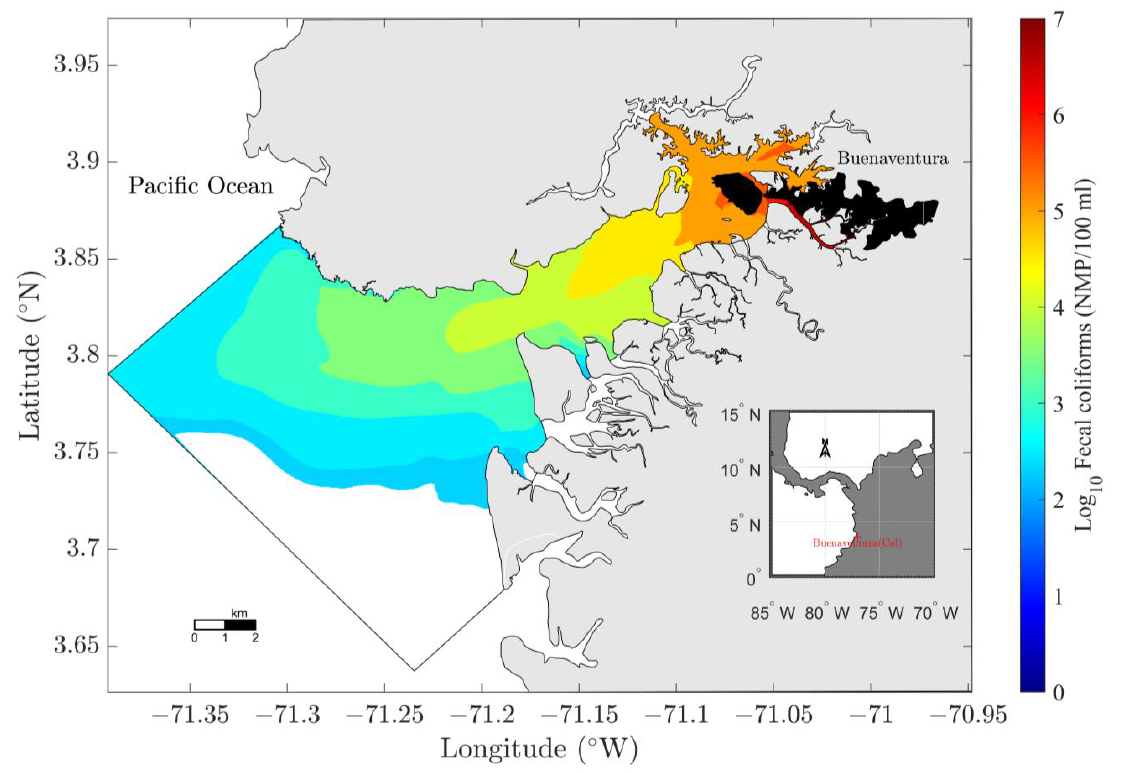
Figure 14. Spatial distribution of the maximum fecal coliform concentration in Buenaventura Bay in scenario three.